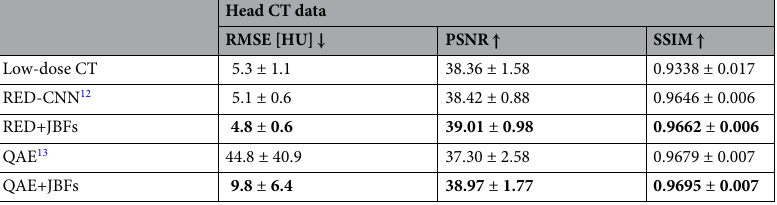
Table 2. Quantitative denoising results on the full head CT data set. The metrics are averaged over all test patients and provided as mean ± std . The respectively better performing network modification is highlighted in